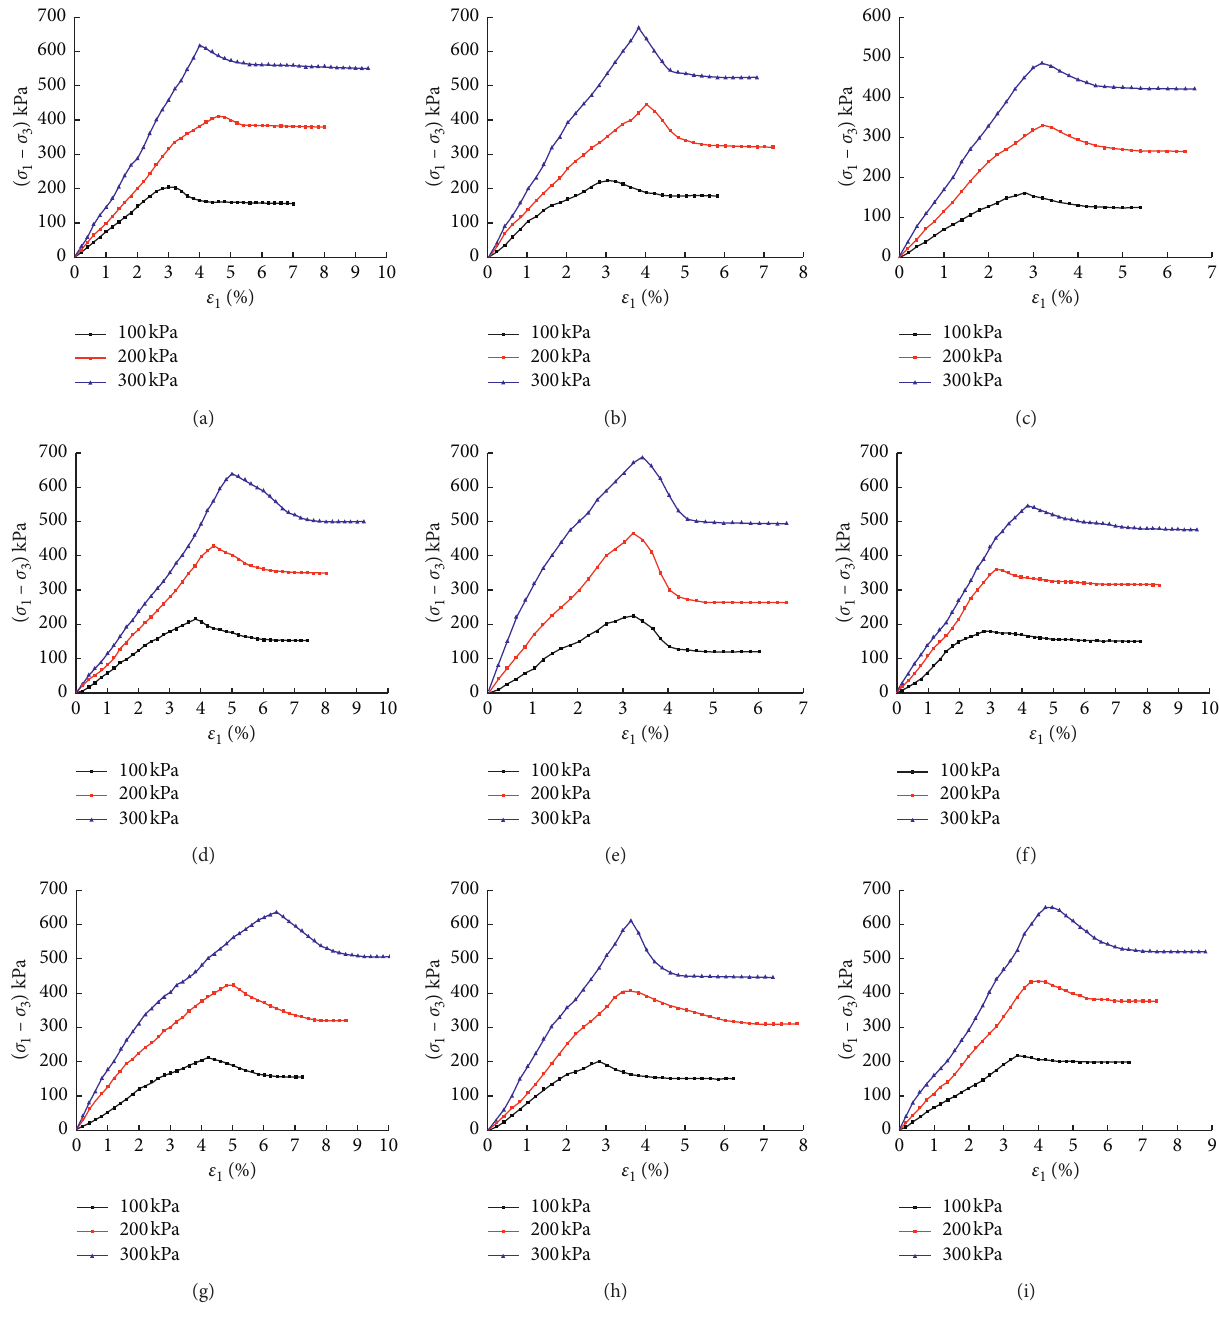
Figure 3: Triaxial shear test stress-strain curves of reinforced loess. (a) Test-1. (b) Test-2. (c) Test-3. (d) Test-4. (e) Test-5. (f) Test-6. (g) Test- 7. (h) Test-8. (i)